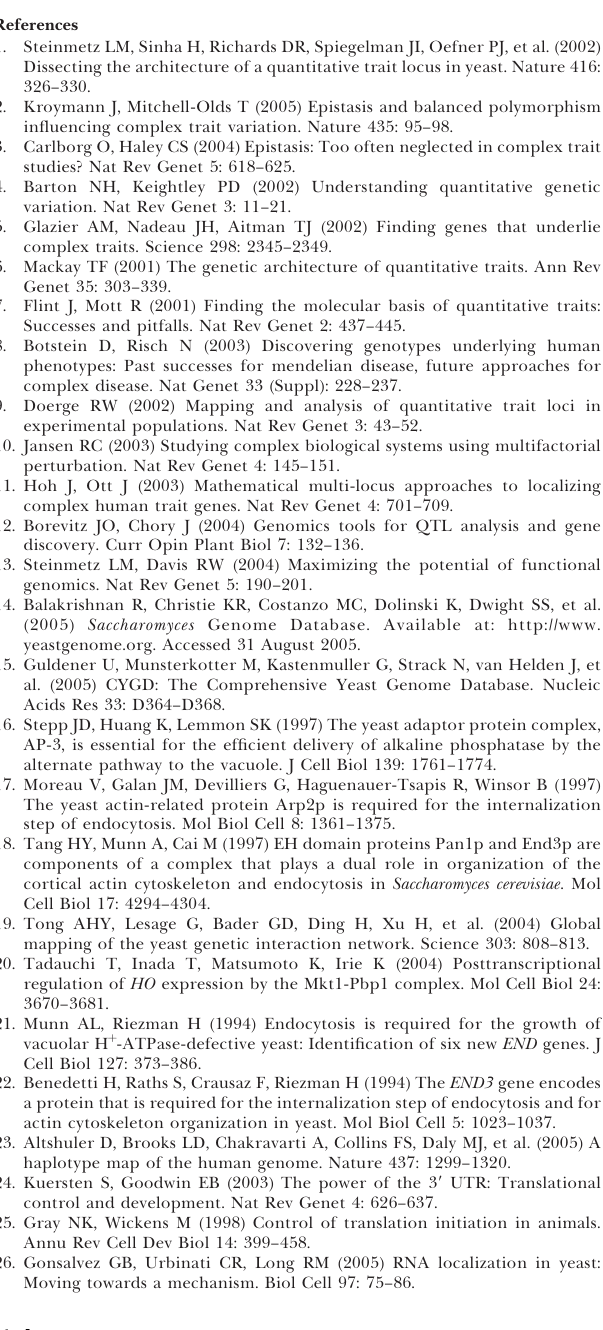
Table S3. Coding, 5 9 UTR, and 3 9 UTR Polymorphisms of MKT1, END3, and RHO2 Alleles in the S288c and YJM Backgrounds Table S4. List of Strains Used in This Study Table S5. List of Oligonucleotides and PCR Primers Used in This